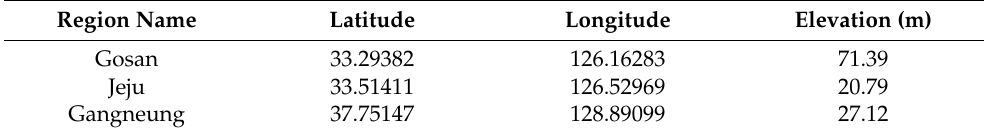
Table 1. Latitudes, longitudes, and elevations of the data collection